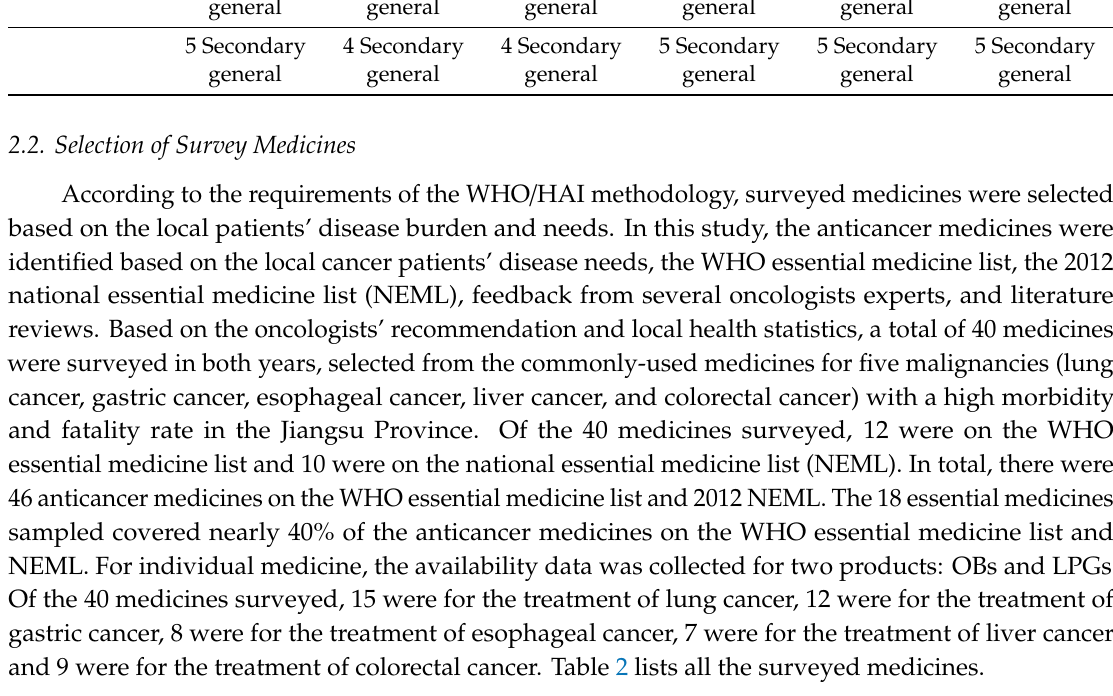
Table 2. List of 40 anticancer medicines surveyed in the Jiangsu